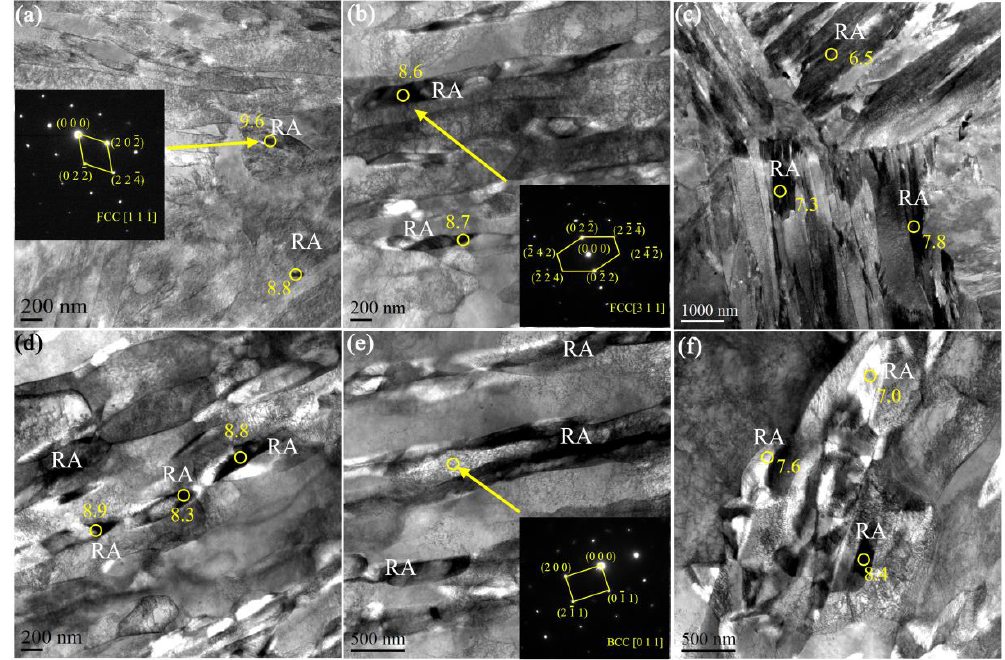
Figure 7. Transmission electron microscope (TEM) micrographs of ( a )–( c ) HR 650 °C sample, ( d )–( f ) CR 650 °C sample. ( a ) granular austenite grains, ( b ) staking faults and filmy austenite grains, ( c ) blocked austenite grains, ( d ) Mn concentration of the selected austenite grains of the CR 650 °C sample determined by TEM-energy dispersive X-ray spectroscopy (EDS), ( e ) filmy austenite grains, and ( f ) Mn content in austenite grains (RA: retained austenite). Table 2. The nominal, equilibrium and measured Mn content in austenite (wt.%) Sample Nominal content Equilibrium content Average measured content